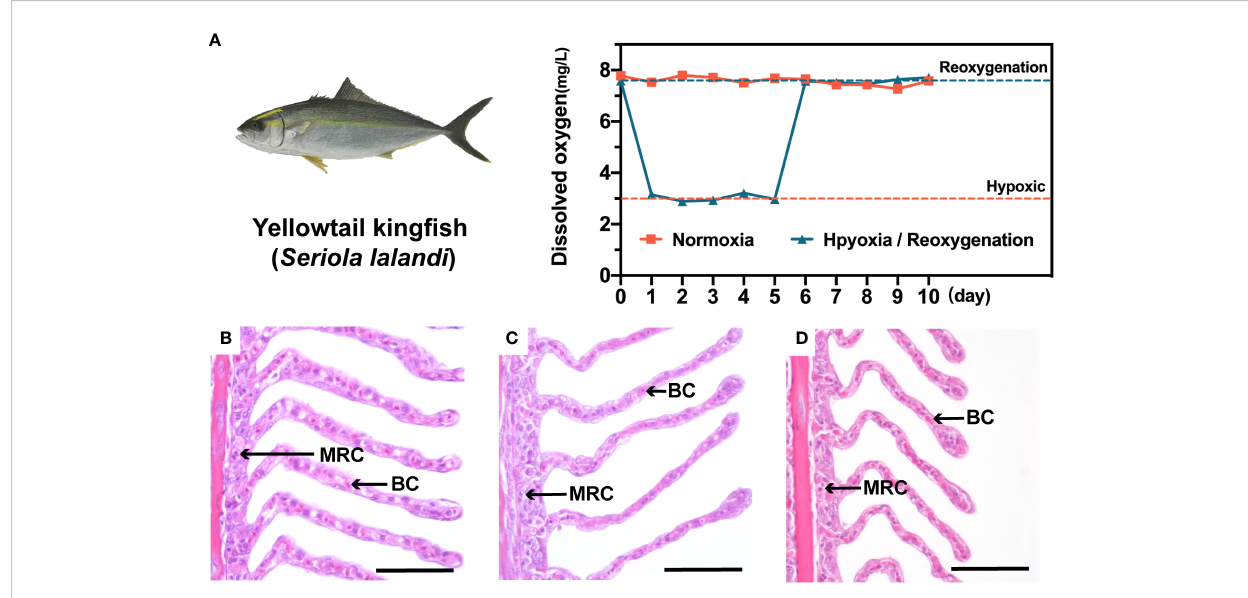
FIGURE 1 (A) Changes in dissolved oxygen levels in the experiment and corresponding gill tissue morphology. (B) is the normoxic level, (C) is the hypoxic level and (D) is the reoxygenation level. Scale bar: 50um.